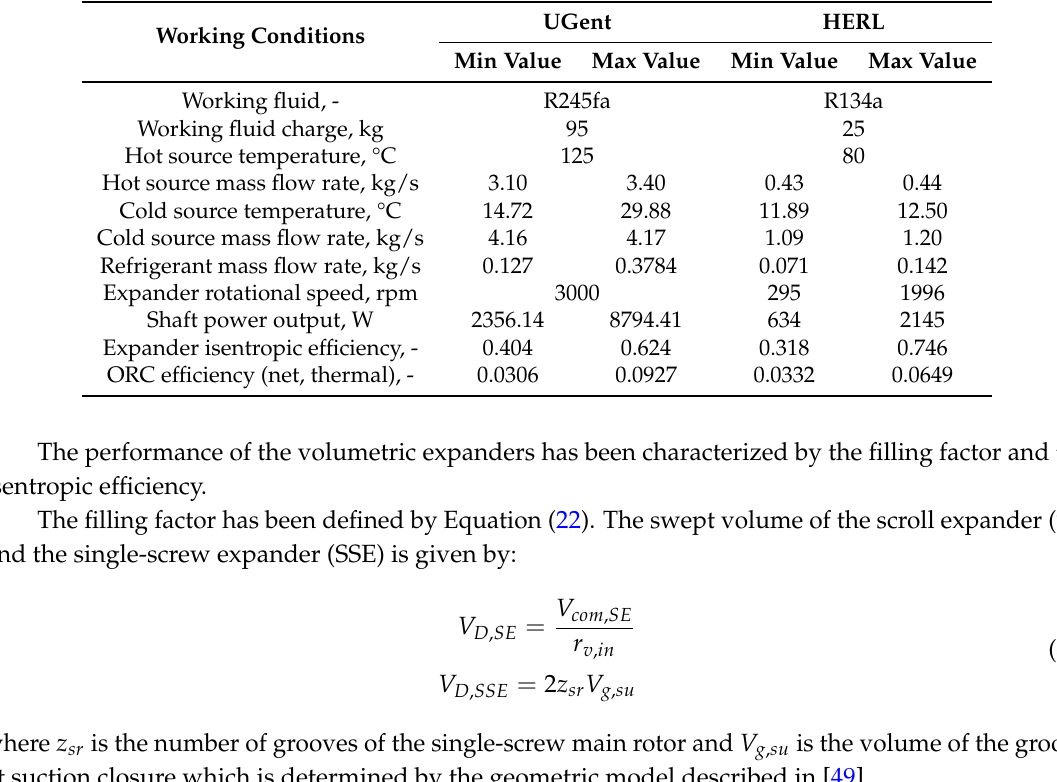
Table 4. Range of working conditions of the two ORCs considered in this